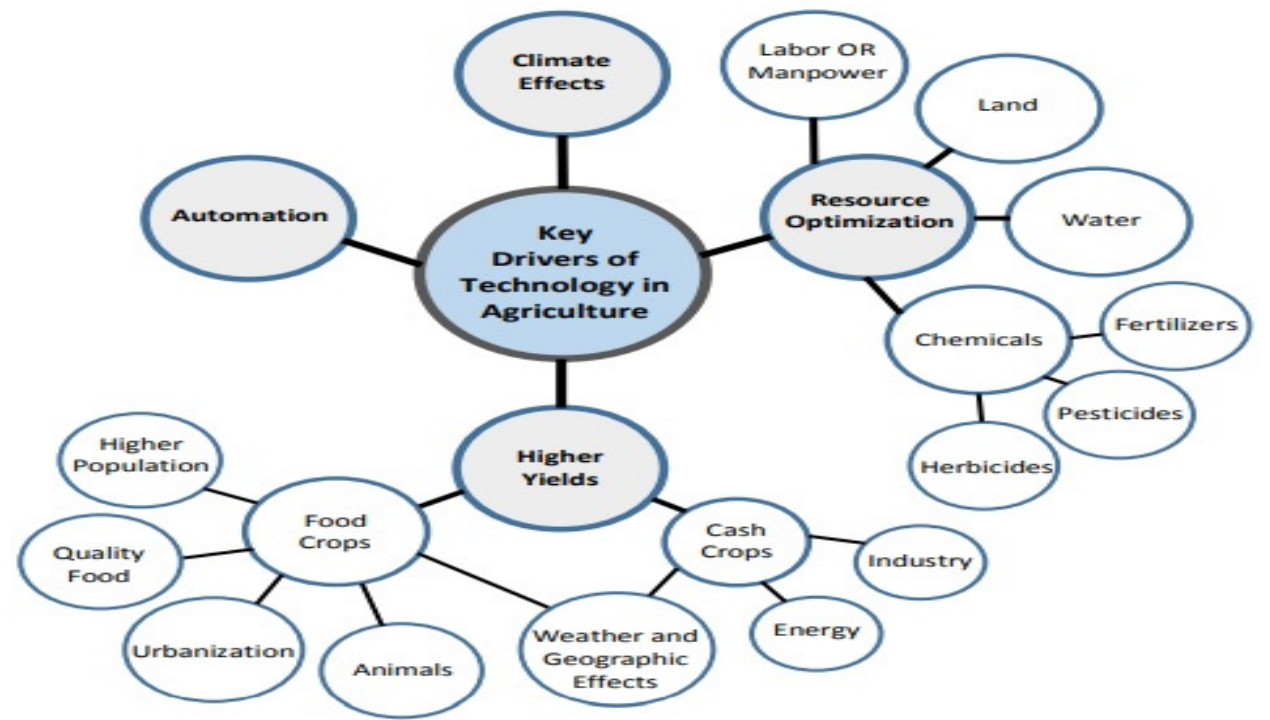
Figure 3. Key drivers of Technology in Agriculture [26].